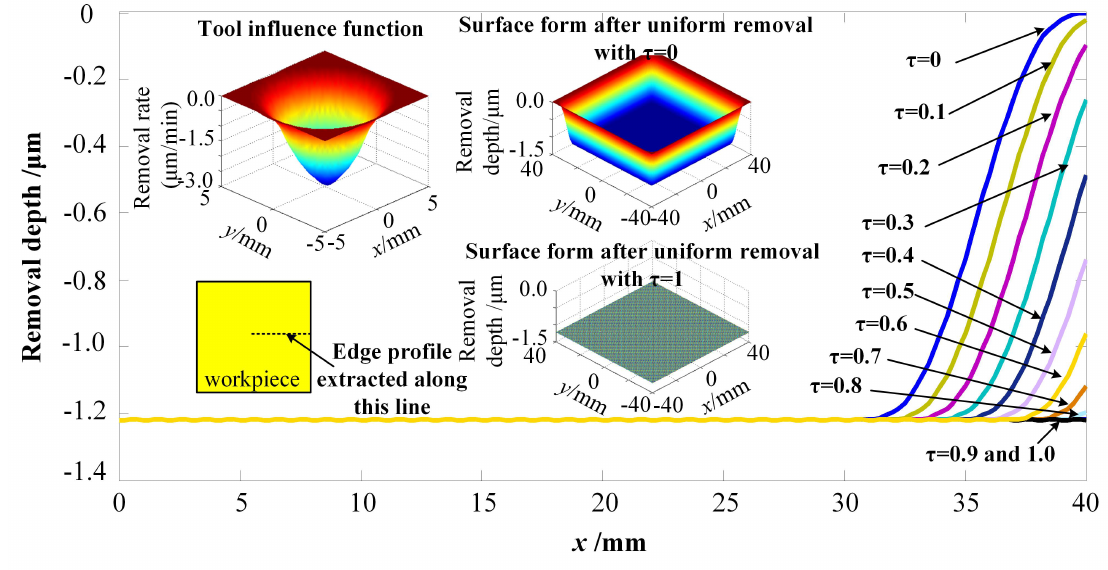
Figure 2. Edge profile after uniform polishing with different overhang